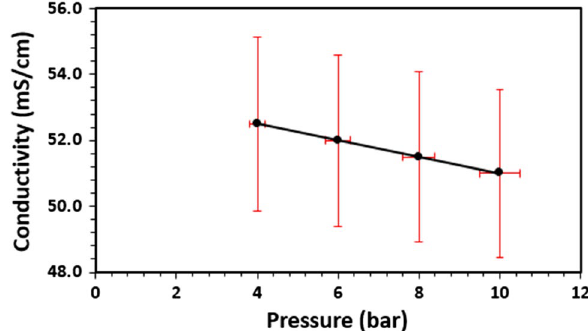
Fig. 7 Effect of different applied pressures on the treatment of the Red Sea water in membrane #1